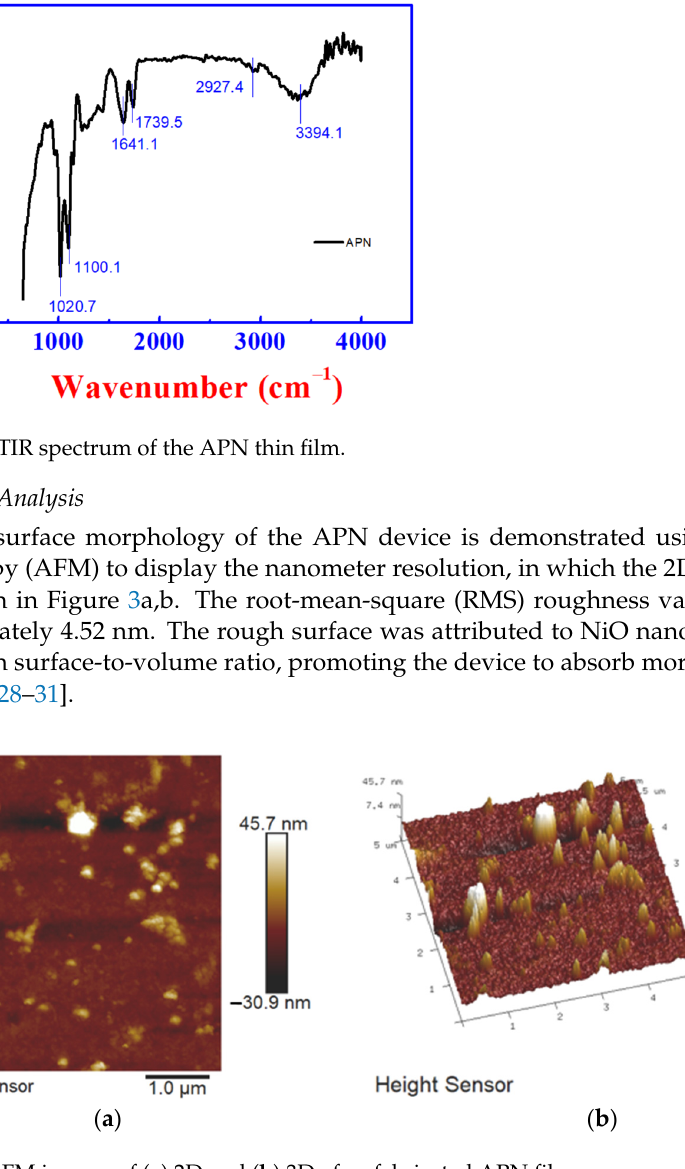
( b ) Figure 1. XPS characterization of ( a ) as-fabricated APN film, and ( b ) high-resolution spectra of O1s. 3.2. FTIR Analysis Figure 2 shows the FTIR spectrum of the APN thin film. The bands around the region